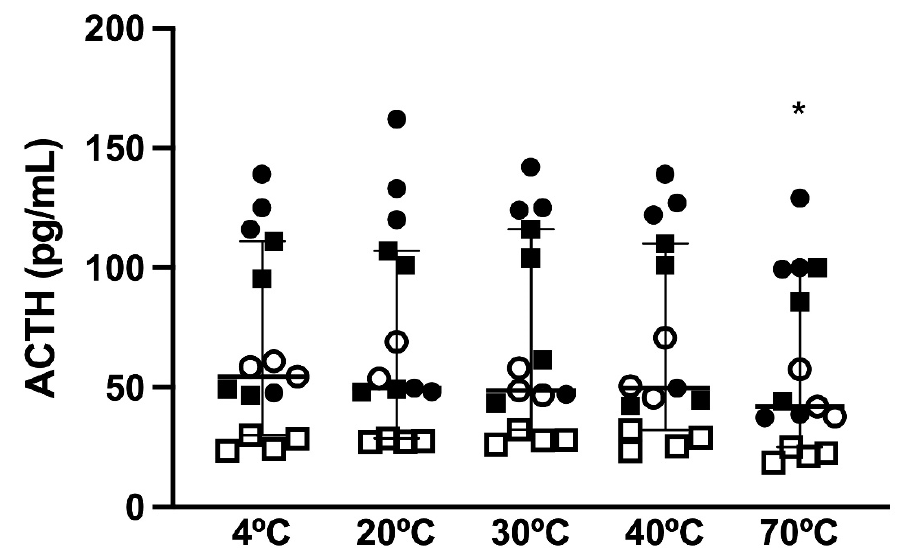
Figure 1. ACTH concentrations in samples kept at 4 (reference sample), 20, 30, 40, and 70 °C in 15 horses (median and 95% CI). Squares represent horses in which the basal ACTH concentration was determined and circles indicate horses in which the post-TRH stimulation ACTH concentration was determined. Hollow shapes represent non-PPID horses and solid shapes indicate horses with PPID. * p < 0.0003 for 4° vs. 70 °C.